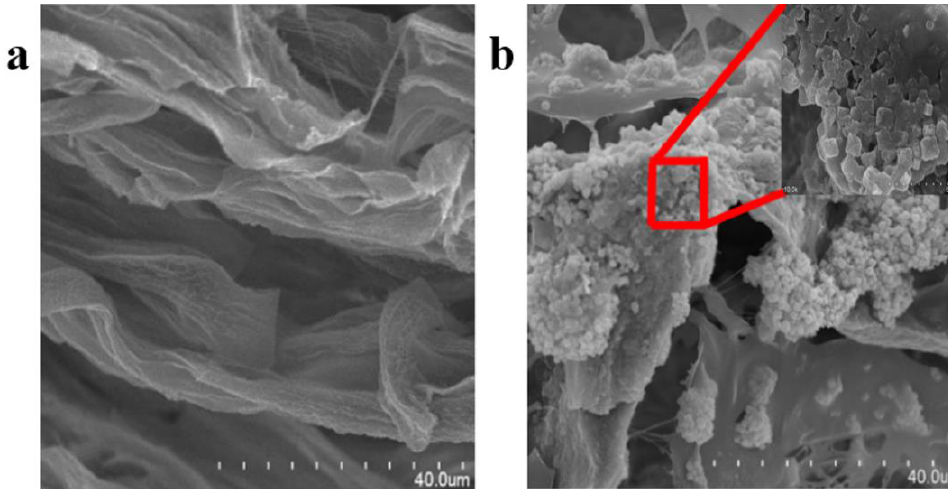
Figure 6. SEM images of ( a ) a blank PVA/CS hydrogel membrane without CA@ZIF-8, and ( b ) a PVA/CS/CA@ZIF-8 composite